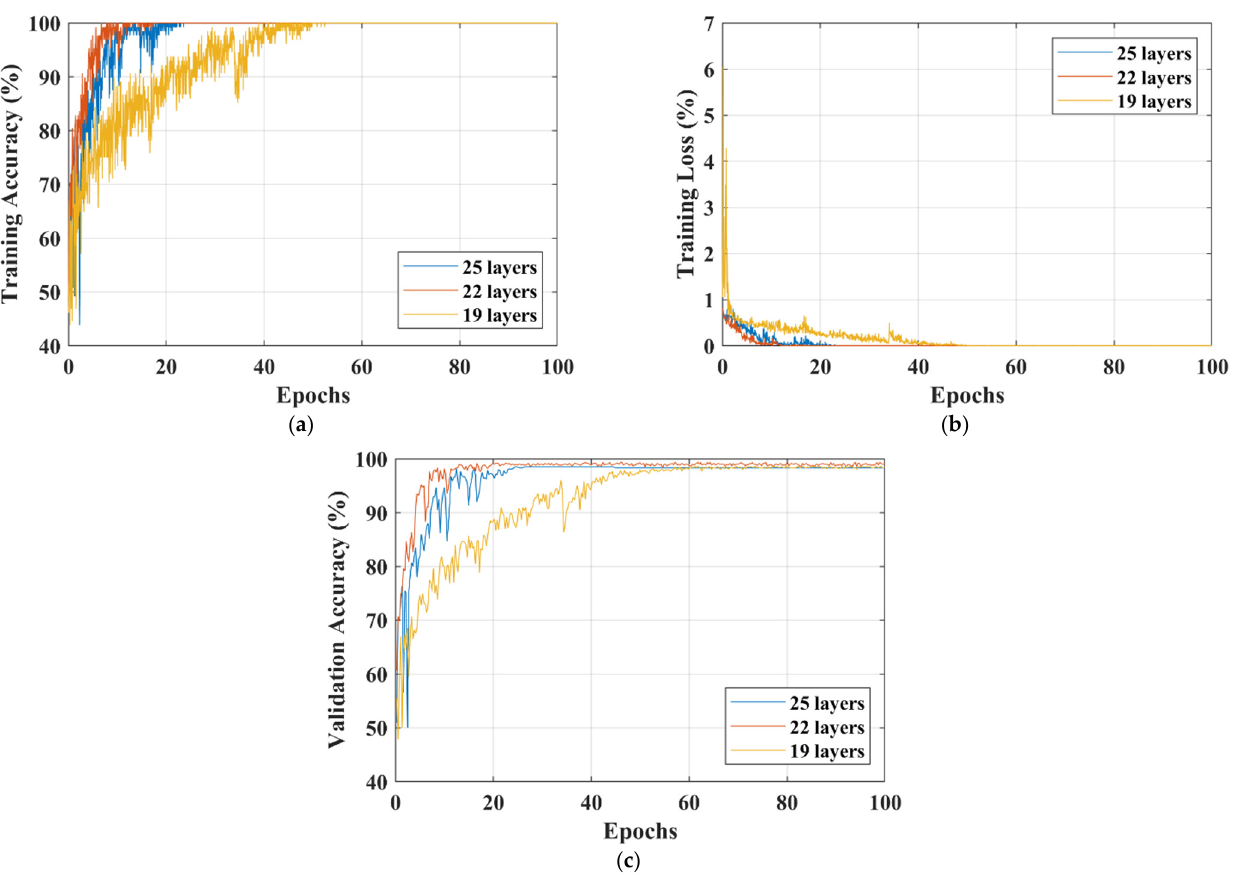
Figure 5. Comparison of different isolated-CNN models for dataset-I; ( a ) Training-accuracy curves; ( b ) Training-loss curves; ( c ) Validation-accuracy curves.